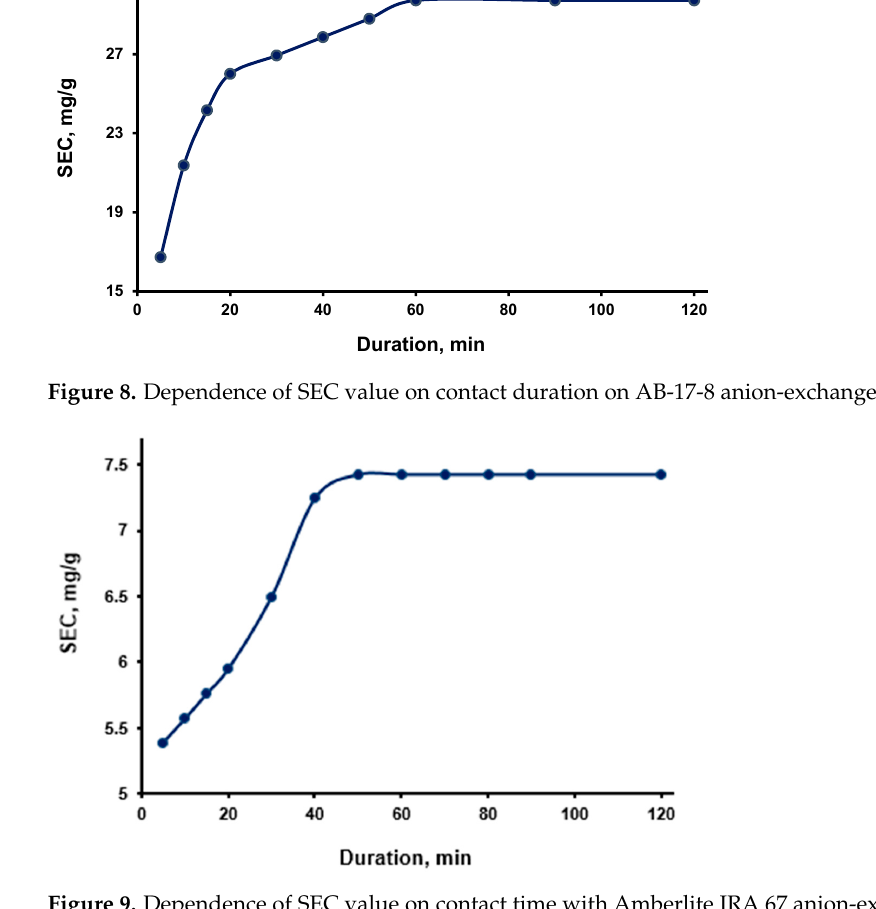
Figure 9. Dependence of SEC value on contact time with Amberlite IRA 67 anion-exchange resin.